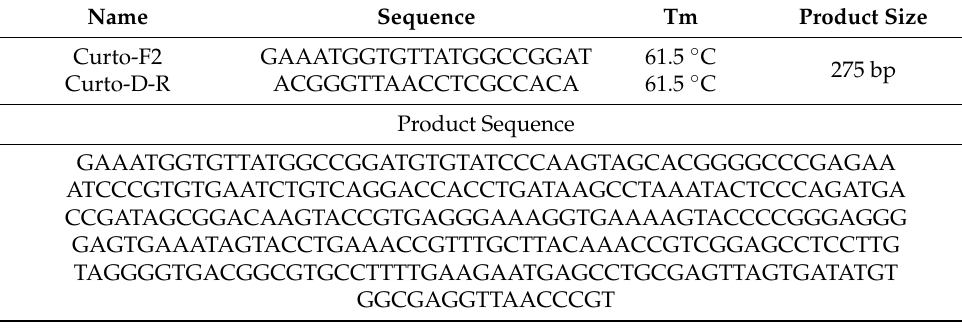
Table 4. Primers and PCR product sequence for the genus-specific detection of Curtobacterium